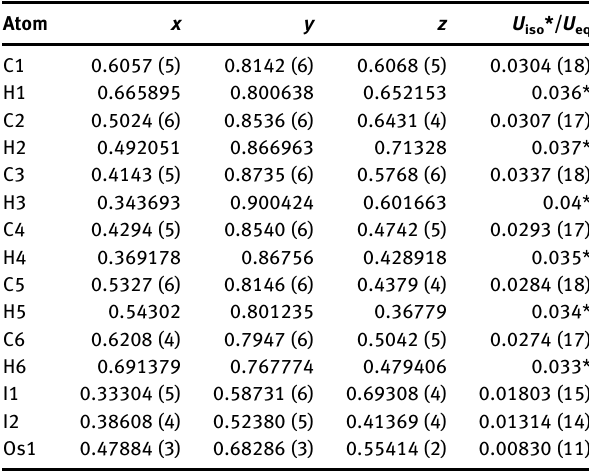
Table  : Fractional atomic coordinates and isotropic or equivalent isotropic displacement parameters (Å 